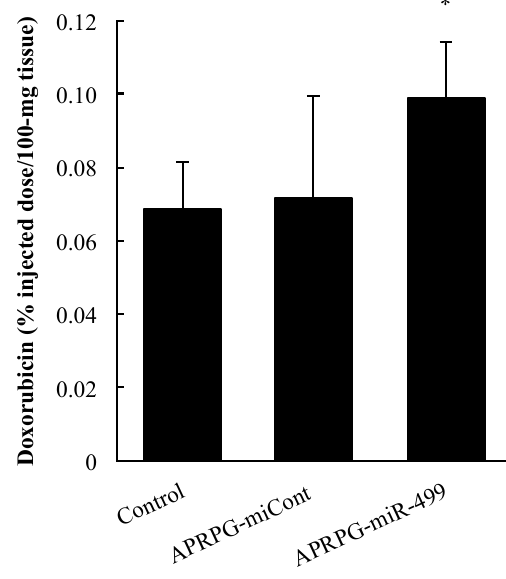
Figure 2. Improvement of DOX accumulation in tumors treated with miR ‐ 499. Colon 26 NL ‐ 17 cells were subcutaneously implanted into the left posterior flank of BALB/c mice. APRPG ‐ miR ‐ 499 or APRPG ‐ miCont were administered intravenously seven days after implantation. Four days after the lipoplex injection, DOX was administered intravenously. Three hours after DOX injection, tumor tissues were excised. The tumors were homogenized with ShakeMan2 and then centrifuged. DOX accumulation was quantified by measuring the fluorescence of DOX (Ex. 470 nm, Em. 590 nm). Asterisks indicate significant differences (* p < 0.05).